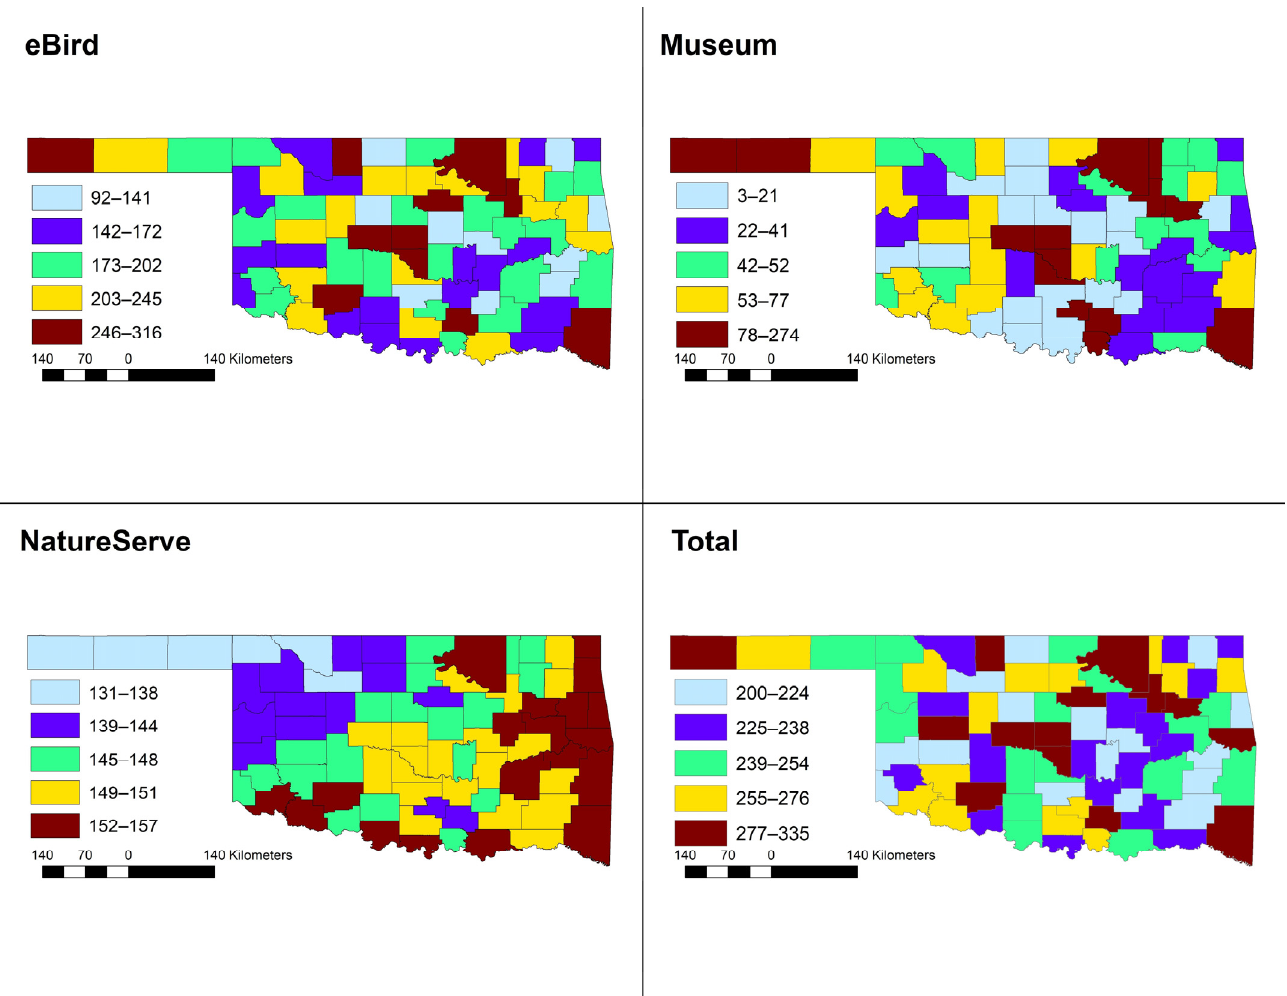
Figure 3. Species richness of species identified or collected grouped by quantiles for eBird, museum collections, composite maps created jointly by BirdLife International and NatureServe, and cumulative totals. Table 2. Total number of species recorded by each method for the 77 counties in Oklahoma.